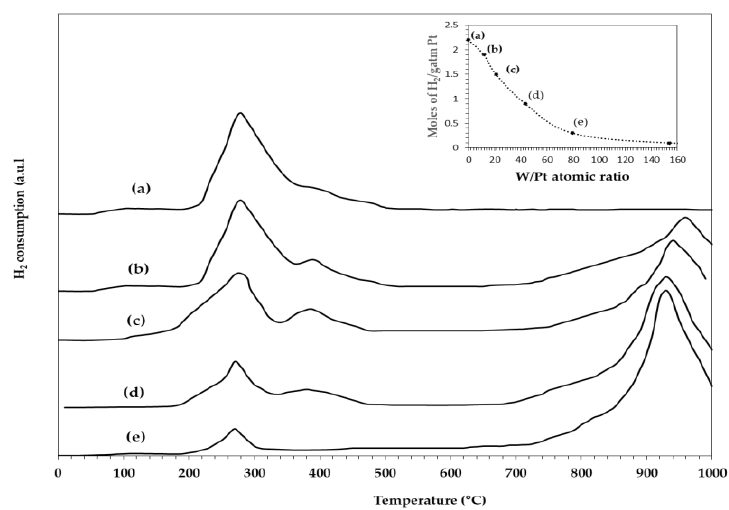
Figure 11. TPR of the Pt/SiO 2 -Al 2 O 3 -WOx catalysts:( a ) Pt100A, ( b ) Pt25SA‒0.5W, ( c ) Pt25SA‒1W, ( d ) Pt25SA‒2W, and ( e ) Pt25SA‒4W. The graphic of the H 2 consumption from the TPR (up to 500 °C) of the catalysts is inserted in the upper inset.